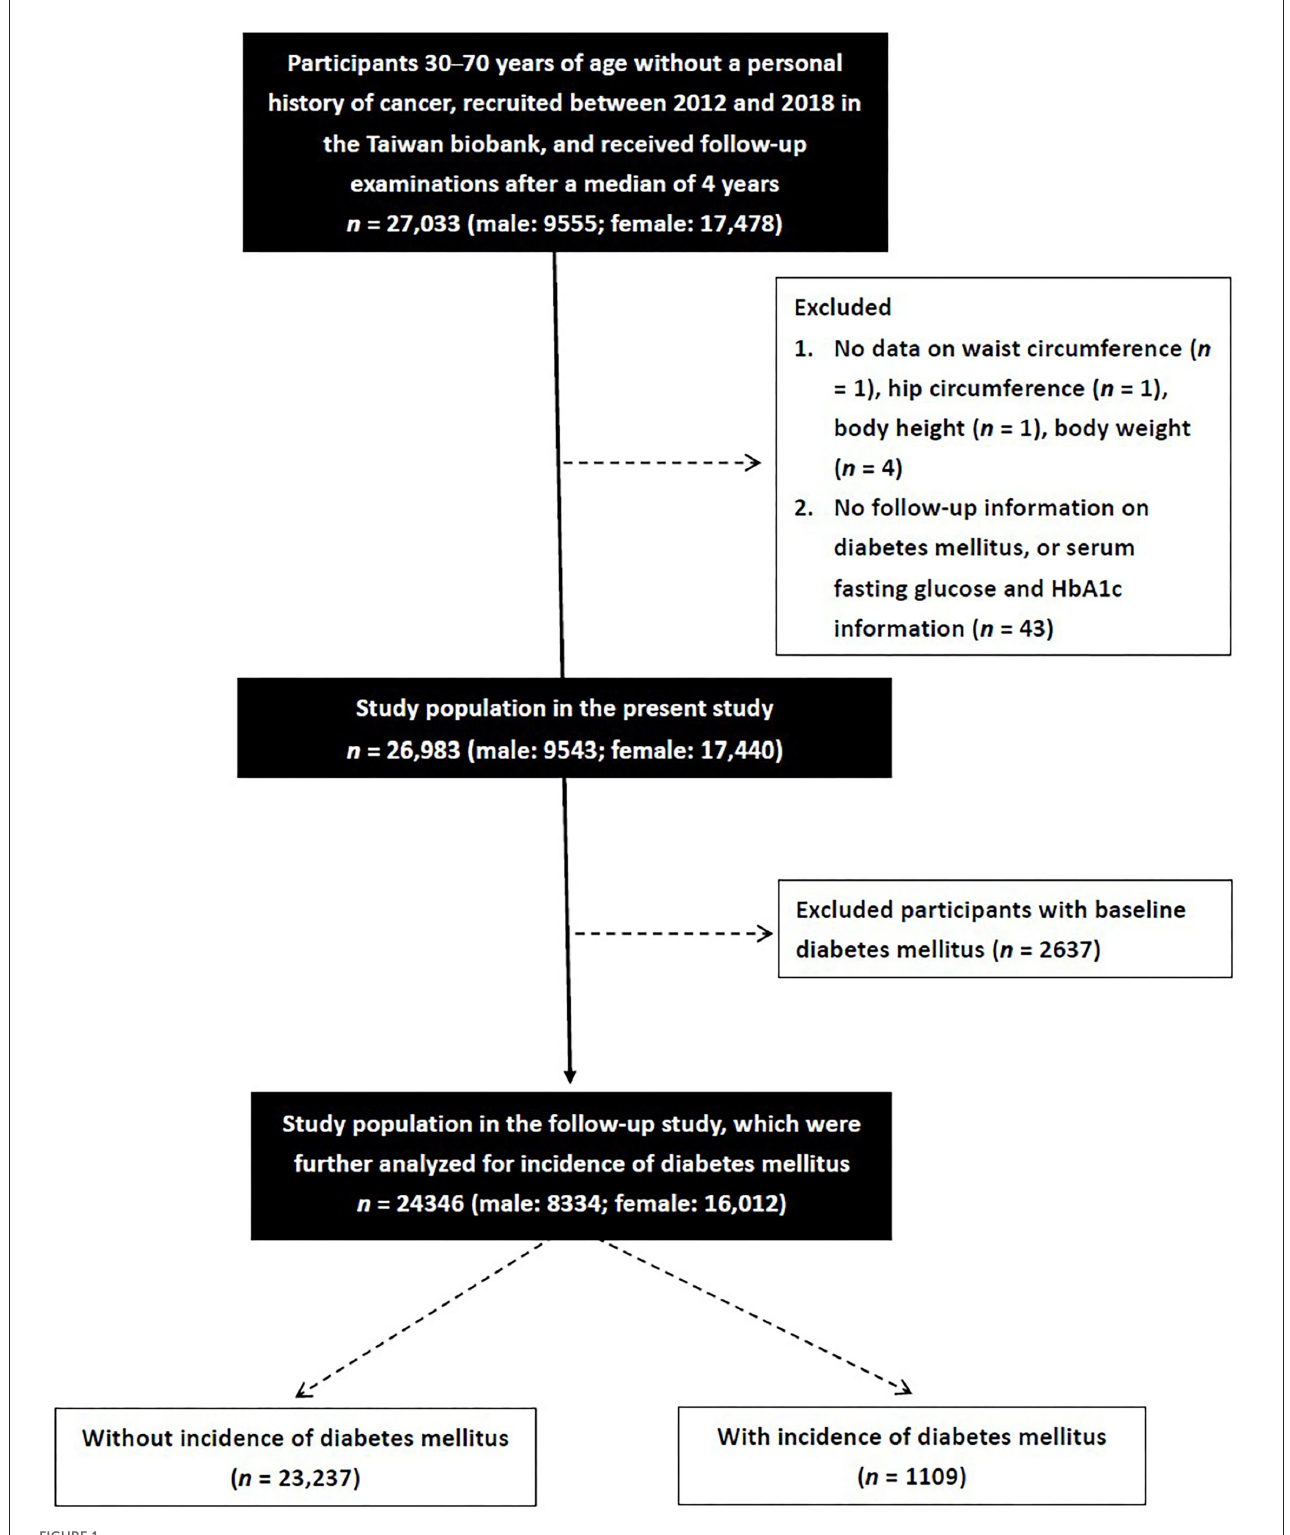
FIGURE1 A total of 27,033 participants were screened. After exclusion those without waist circumference, hip circumference, body height, body weight, follow-up data on diabetes mellitus, serum fasting glucose or HbA1c, and those with baseline diabetes mellitus, the remaining 24,346 participants were